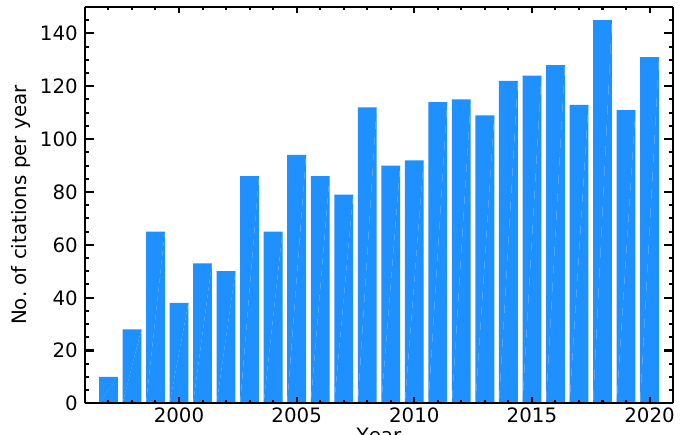
Figure 1. Current status of yearly direct citations to the CHIANTI